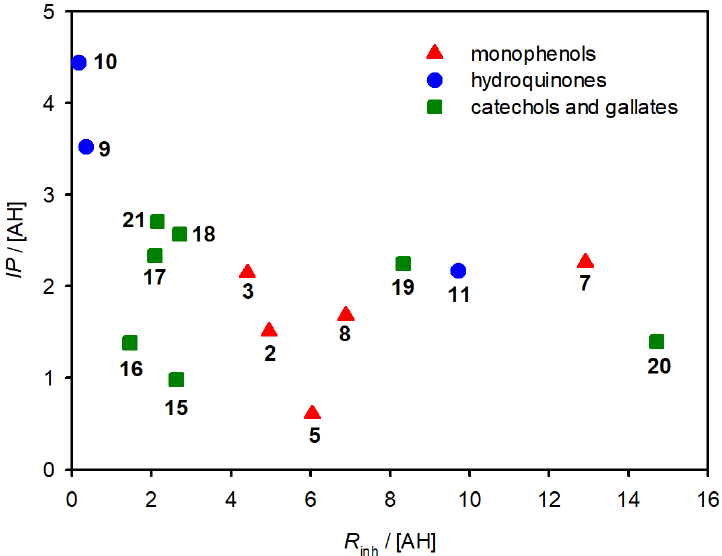
Figure 5. Relation between R inh and IP divided by the molar antioxidant concentration (in arbitrary units). Antioxidants with undefined IP were omitted.